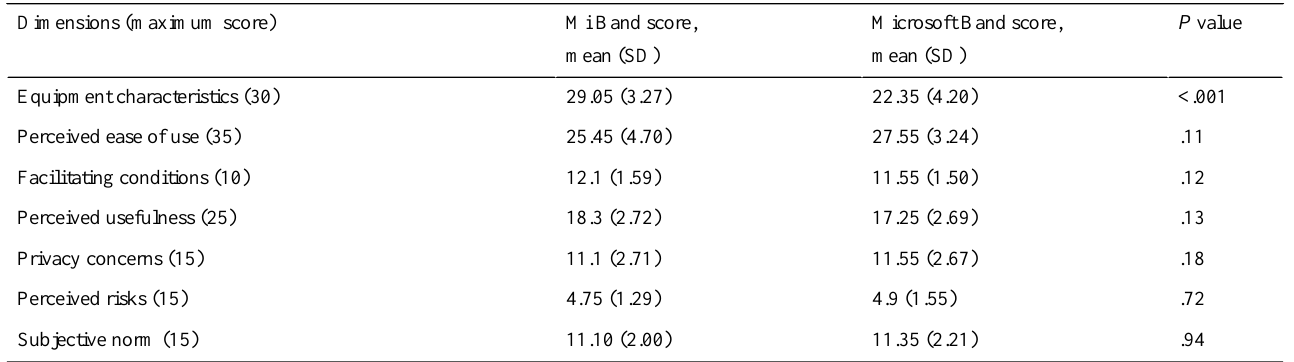
Table 5. Differences in the technology acceptance questionnaire scores per dimension for each device.